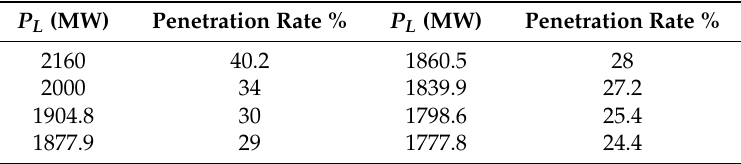
Table 1. Corresponding relationship of load and wind power